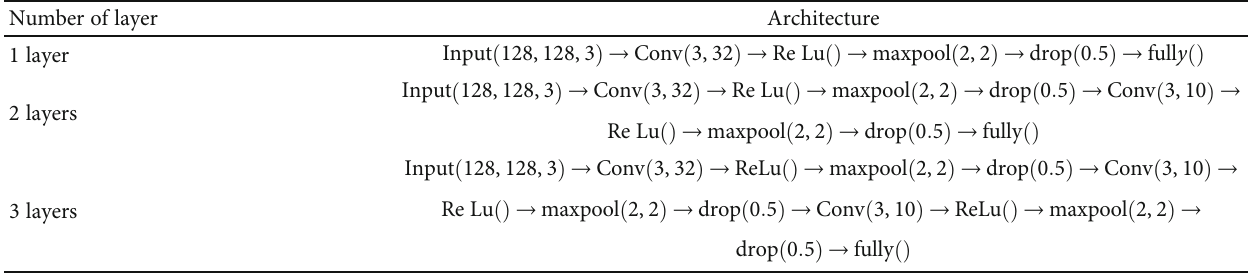
Table 1: The proposed CNN architecture.